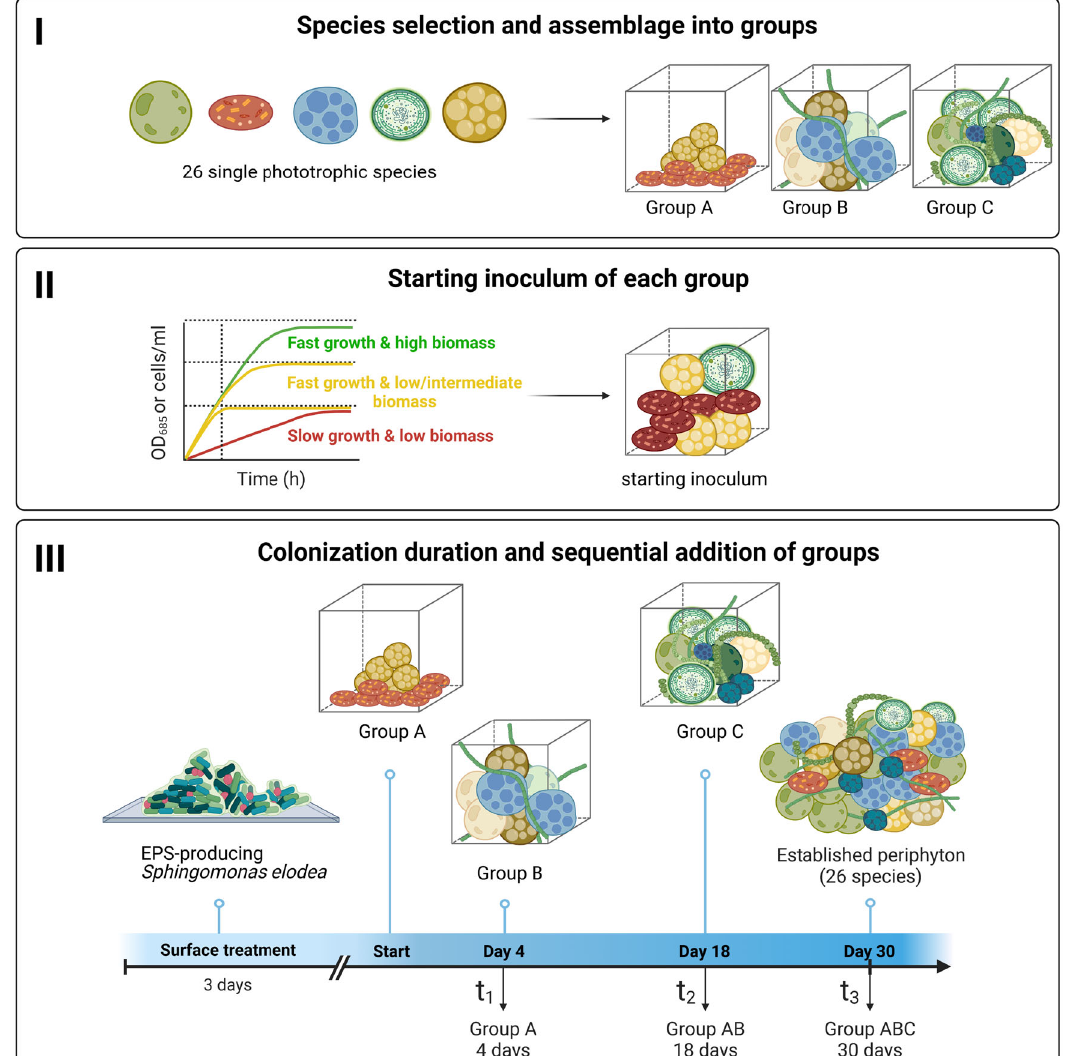
Fig. 1 Schematic representation of the work fl ow to establish the synthetic periphyton. Twenty-six phototrophic microbial species were selected based on their ability to grow under the same conditions and their frequent detection in natural freshwater periphyton. The selected species were then assigned to three groups ( I ). The cell density in the starting inoculum for each group was determined based on the growth rates and reached maximum biomass of each single species ( II ). Groups were added sequentially onto growth chambers covered with the EPS-producing bacteria Sphingomonas elodea . Time points for the addition of the groups and colonization durations for each phototrophic group were determined experimentally ( III ) (Illustration created with